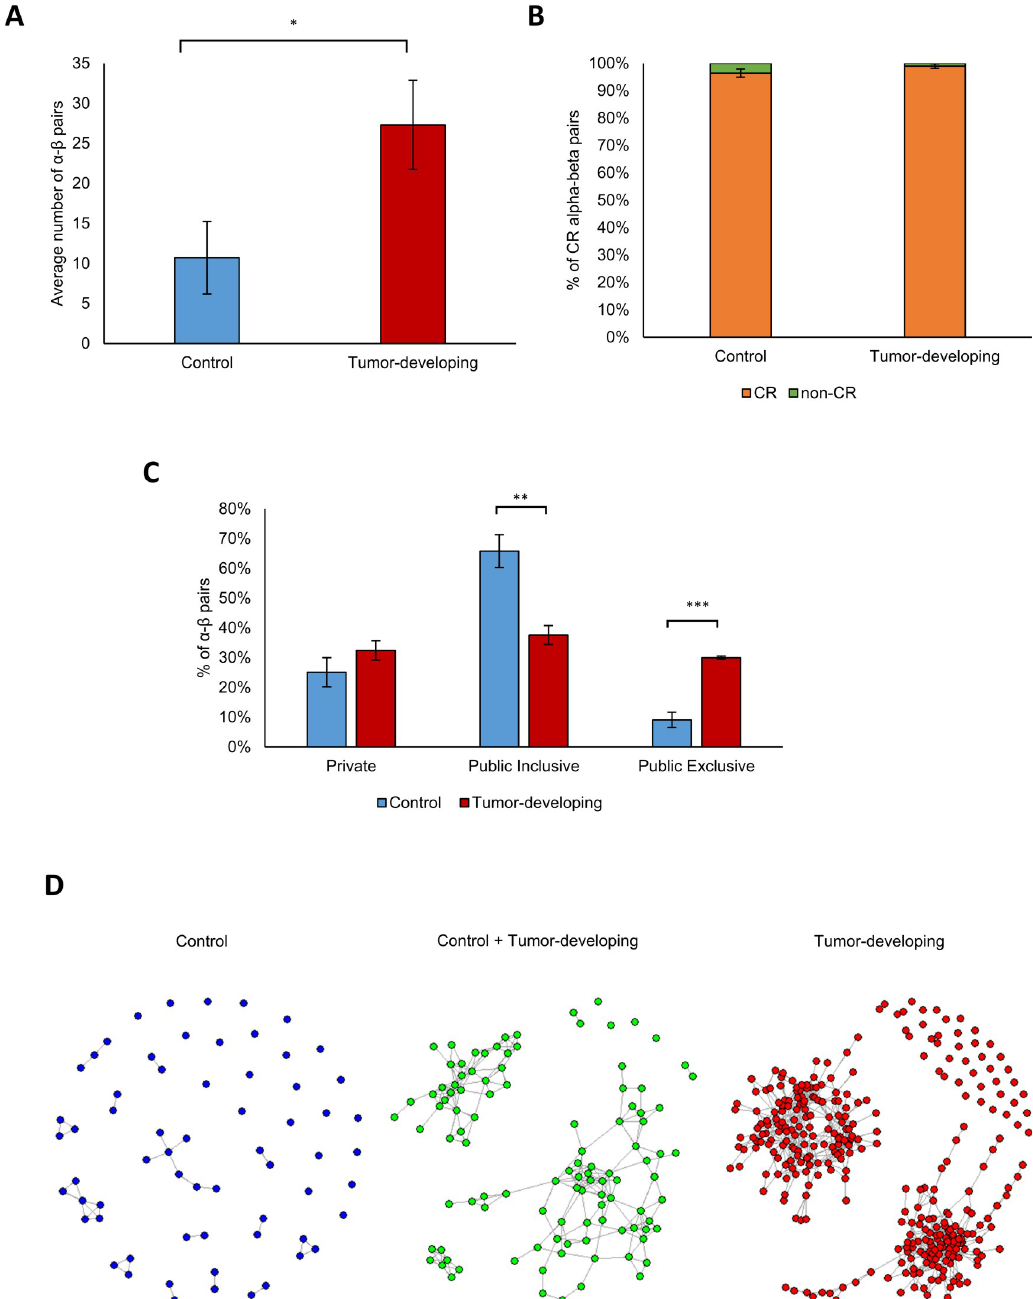
Fig 7. Transgenic mice share a higher similarity with human breast cancer patients than Control mice. (A) The number of different human α - β pairs shared with our mouse data within the Control group (blue bar) and the Transgenic group (red bar). (B) The percent of convergent recombined (CR) human α - β pairs in the Control and Transgenic mice. (C) The percent of the different Public groups (Private, Public-Inclusive and Public-Exclusive) in the Control group (blue bars) and the Transgenic group (red bars). (D) Distance networks of all the α - β pairs shared with our mice subsampled data that appear only in the Control group (blue network), only in the Transgenic group (red network) and in both groups (green network).